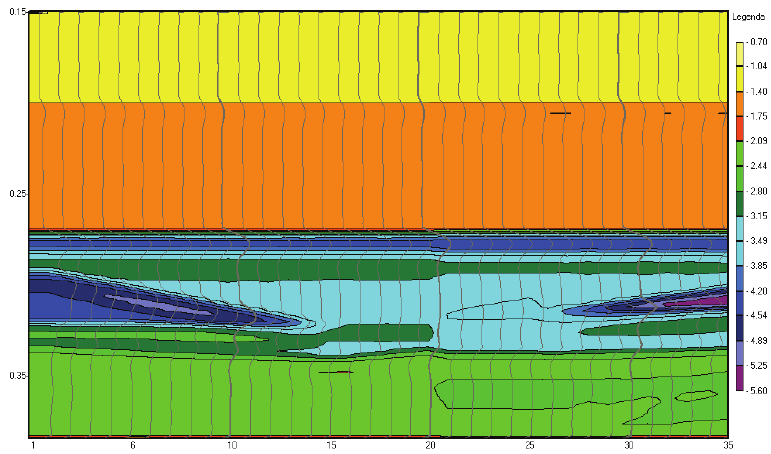
Fig. 8. Synthetic pseudoimpedance acoustic section with MED deconvolution; signal parameters: dominant frequency f 0 = 40 Hz, initial phase φ 0 = 0,